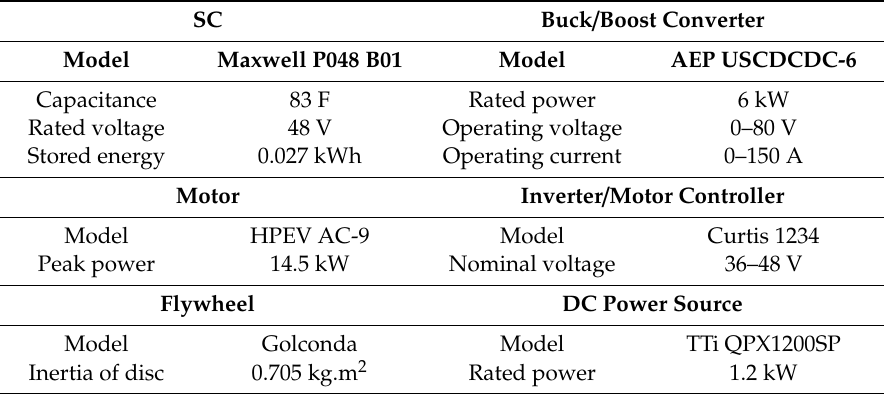
Table 1. List and details of the components used in the regenerative braking test